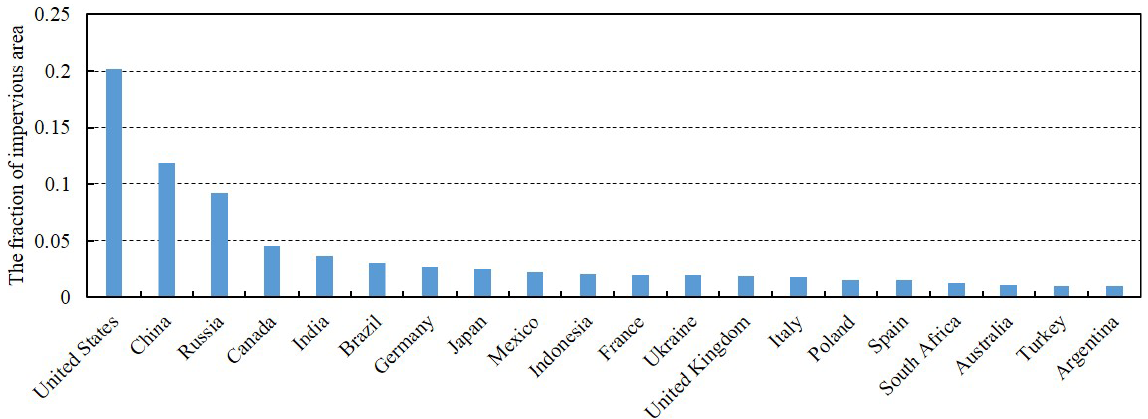
Figure 6. The top 20 countries in terms of impervious surface area and corresponding fractions of the global total.